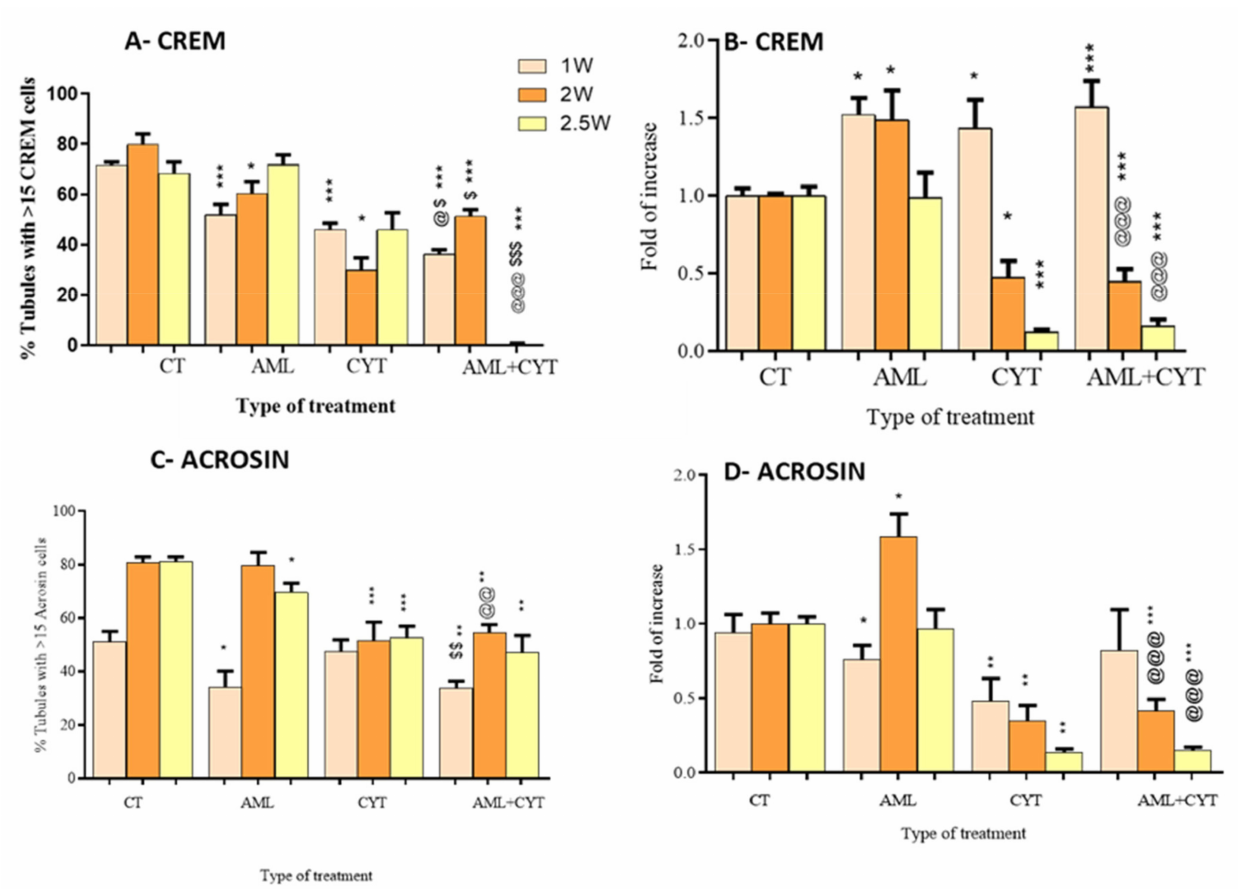
Figure 5. Effect of AML and CYT on the presence and expression levels of meiotic/post-meiotic markers. Mice and testes were treated as described in Figure 1. Testes were removed after 1, 2 or 2.5 weeks and fixed or used for RNA extraction. Fixed testicular tissues were immunoassayed with specific anti-CREM and anti-acrosin antibodies to identify meiotic/post-meiotic cells. Tubules with more than 15 CREM-positive cells ( A ) and ACROSIN-positive cells ( C ) are presented as % of tubules. The RNA expression levels of CREM ( B ) and ACROSIN ( D ) in the testes isolated from each treatment group were examined by qPCR analysis using specific primers, and housekeeping gene (GAPDH) was used as internal control. The results are presented as fold of increase compared to GAPDH ( B ). N (number of repeats of all treatments) = 3; n = (number of mice examined from all the experiments for each treatment (immunostaining) = 6–9/group; #tubules/group = 40–120; n = 5–7/group (RNA expression). * ( p < 0.05), ** ( p < 0.01), *** ( p < 0.001) significant relative to control group. @ ( p <